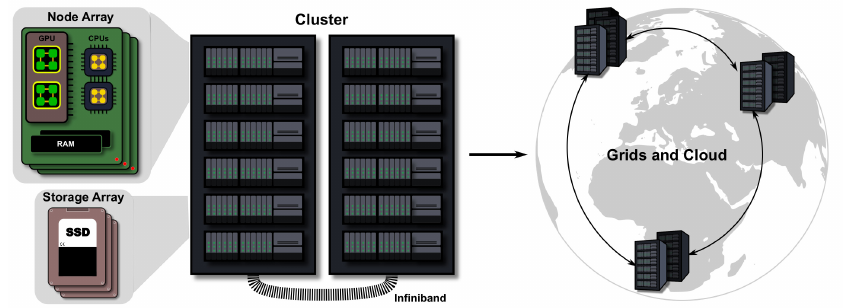
Figure 4. Powerful chips to Cloud